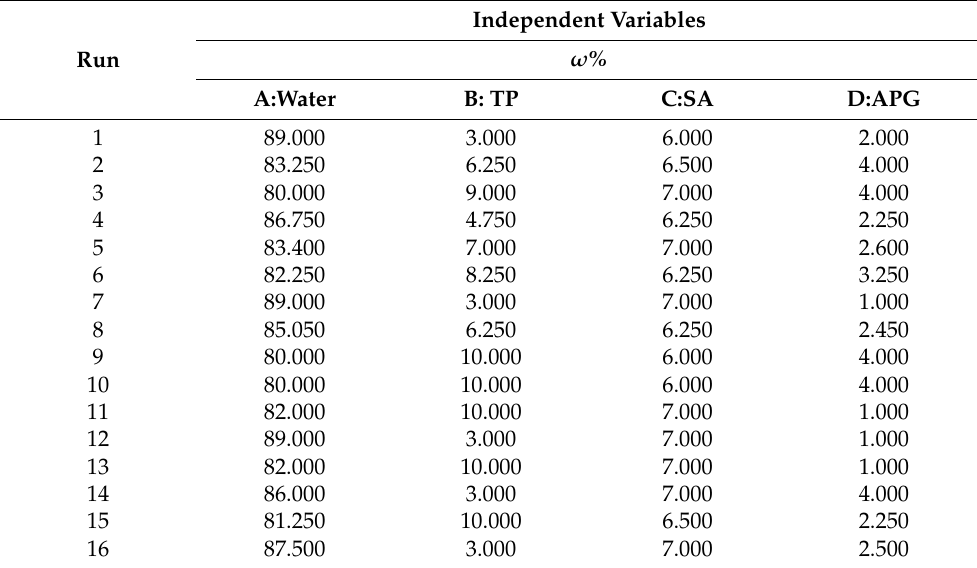
Table 3. D-optimal experimental design for the compound settling suppressant